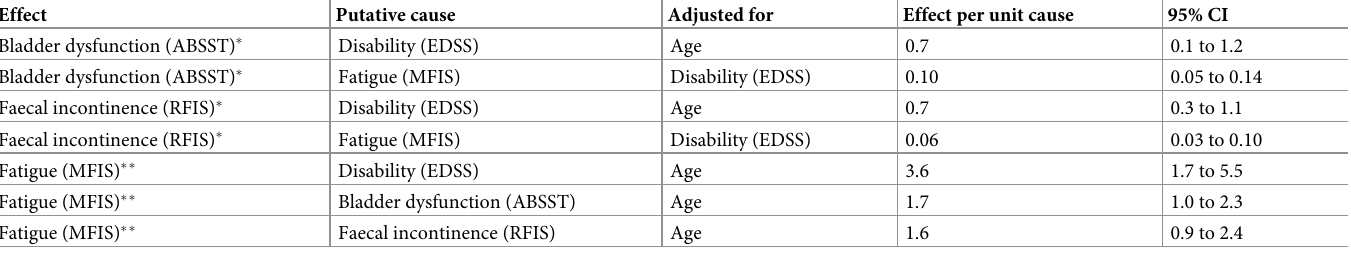
Table 2. Relationship between level of disability, bladder dysfunction, bowel dysfunction, and fatigue. EDSS: Expanded Disability Status Scale (range 1–10); MFIS: Modified Fatigue Impact Scale (range 1–84); ABSST: Actionable Bladder Symptom Screening Tool (range 1–24); RFIS: Revised Faecal Incontinence Scale (range